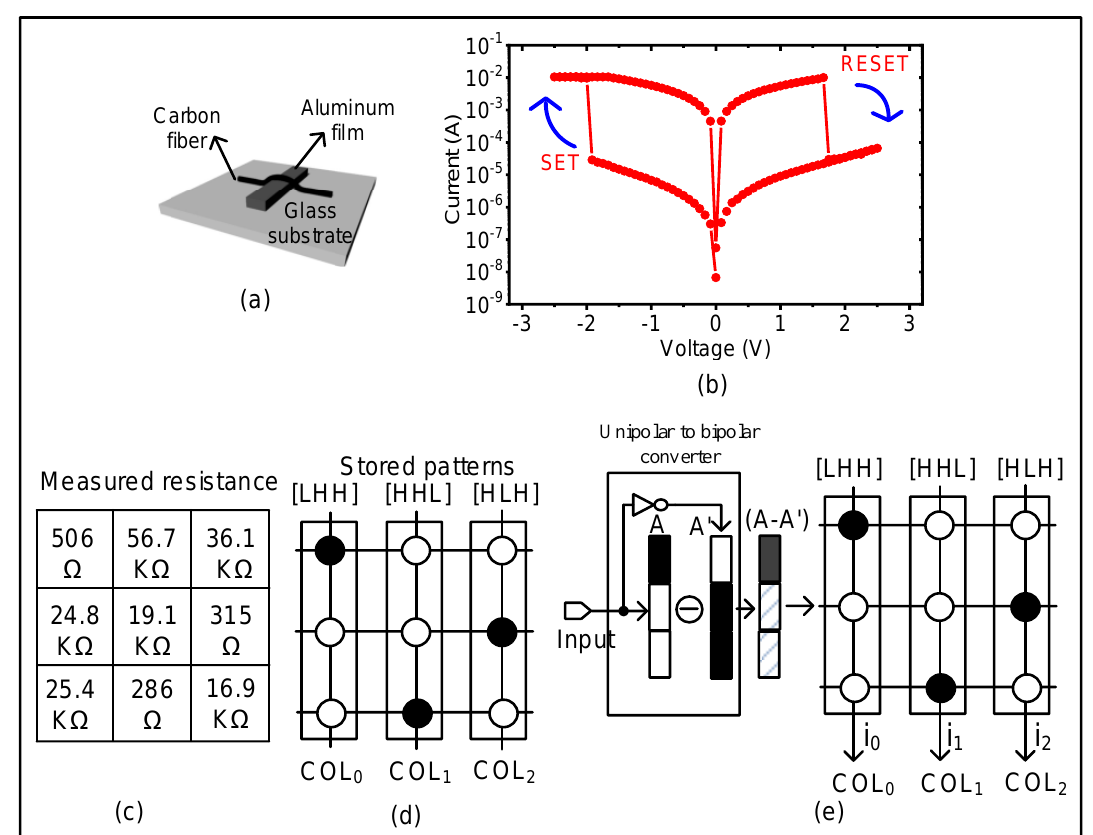
Figure 8. Experimental test of the single crossbar array architecture for recognizing three patterns: ( a ) schematic of the fabricated memristor device based on carbon fiber and aluminum film (Repro- duced with permission from [22], published by published by SpringerOpen); ( b ) the measured cur- rent – voltage of the fabricated memristor in which the applied voltage was swept from -2.5 V to +2.5 V and vice versa (Reproduced with permission from [22], published by published by SpringerOpen); ( c ) the measured memristance of the fabricated 3 × 3 memristor crossbar (Repro- duced with permission from [22], published by published by SpringerOpen); ( d ) the pattern stored in the 3 × 3 memristor crossbar; ( e ) conceptual diagram of the single crossbar architecture for rec- ognizing three patterns (Reproduced with permission from [16],published by IEEE).